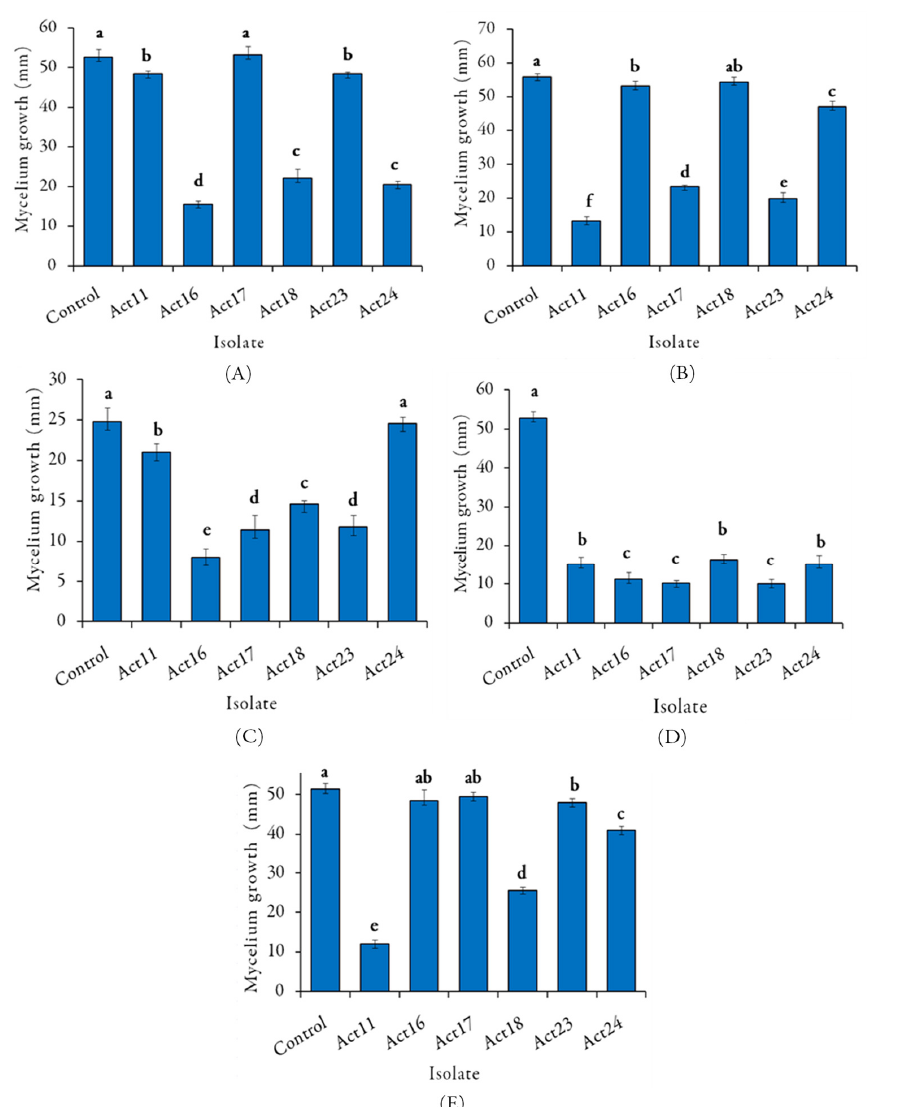
Figure 1. In vitro bioassay activity of actinomycetes isolates in mm against fungi; (A): A. flavus ; (B): F. solani ; (C): B. cinerea ; (D): A. alternata ; (E): F. oxysporum Data are reported as the mean ± SD of five parallel measurements. Values with different superscripts (a, b, c, d, or e) in the same column differ significantly (ANOVA test, p < 0.05).